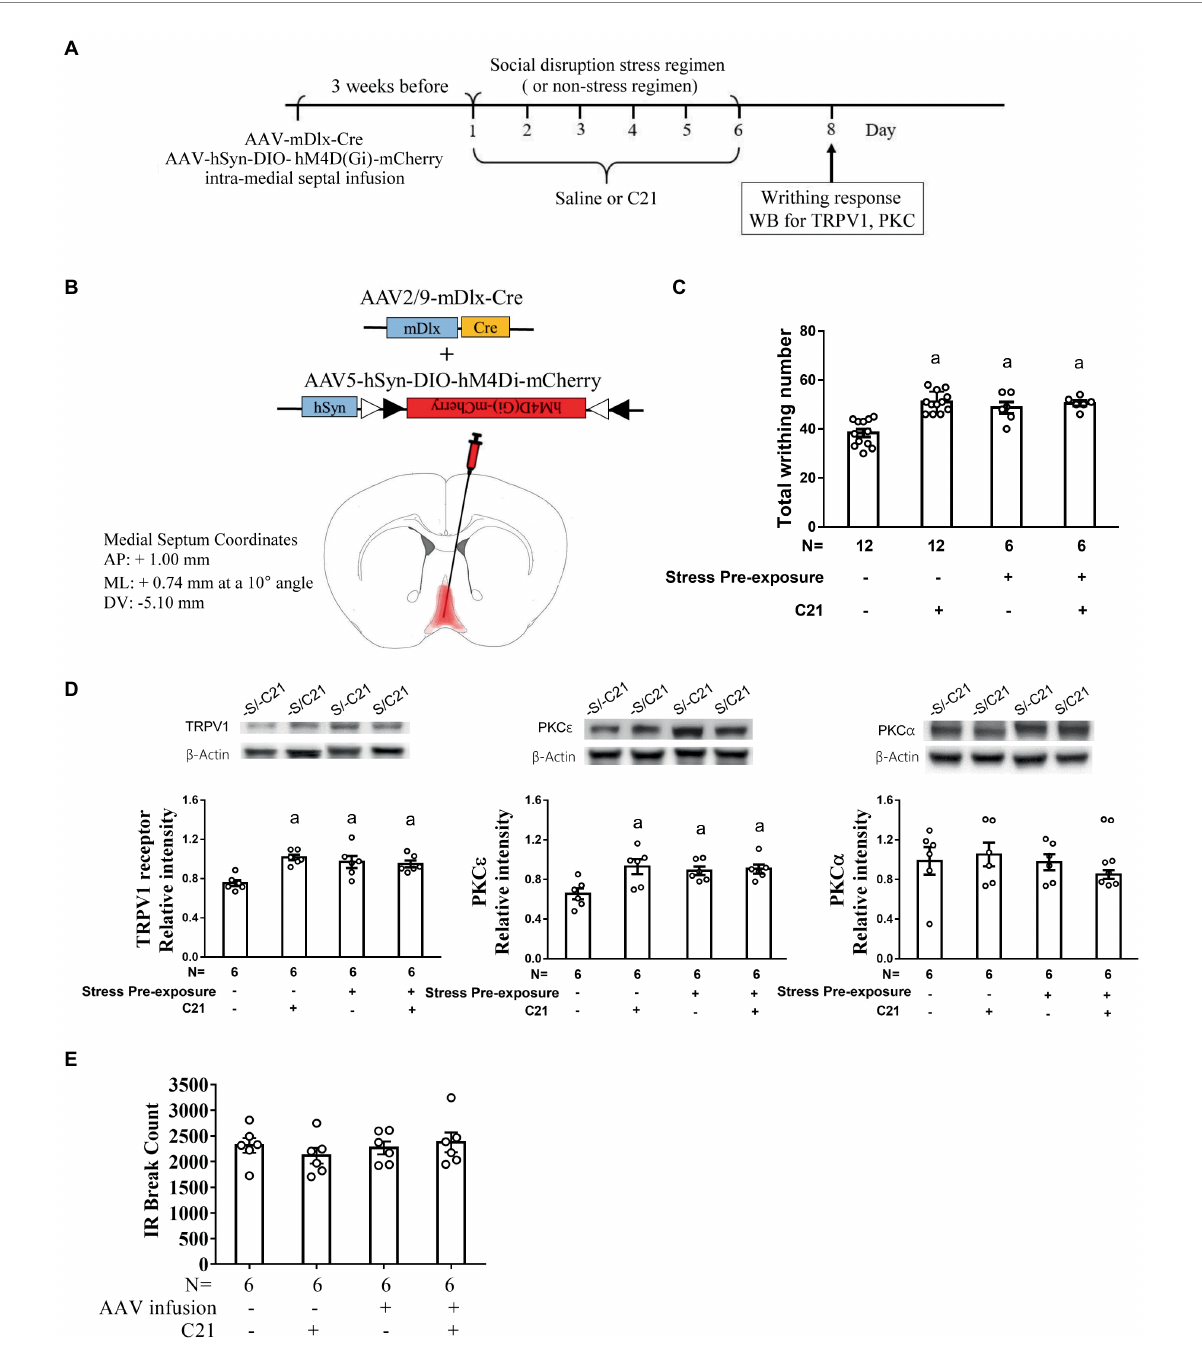
FIGURE 4 Dampening medial septal GABAergic activity mimicked stress-primed effects on writhing response and accumbal TRPV1 and PKC ε level. (A) Timeline for viral infection, C21 treatment, the stress regimen, writhing response test and Western assay. (B) Intra-medial septal viral mixture infusion. Viral mixture consists of AAV2/9-mDlx-Cre (2.84 × 10 12 gc/ml) and AAV5-hSyn-DIO-hM4Di-mCherry (2.7 × 10 13 gc/ml). Superimposed red shaded area indicates all confirmed AAV-mCherry labeling results. (C) Total acetic acid-induced writhing responses. a Significantly greater than the –S/–C21 control group. (D) Accumbal TRPV1, PKC ε and PKC α level. a Significantly greater than the –S/–C21 control group. (E) No effects of C21 or intra-medial septal viral infusion on animals’ locomotor activity. Graphs show mean ±